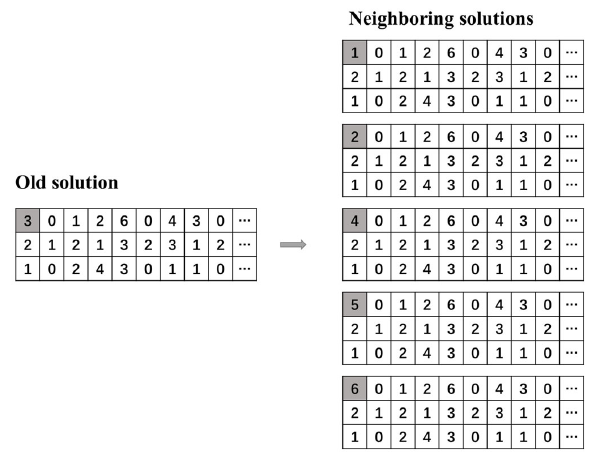
Fig. 8. The neighboring solutions